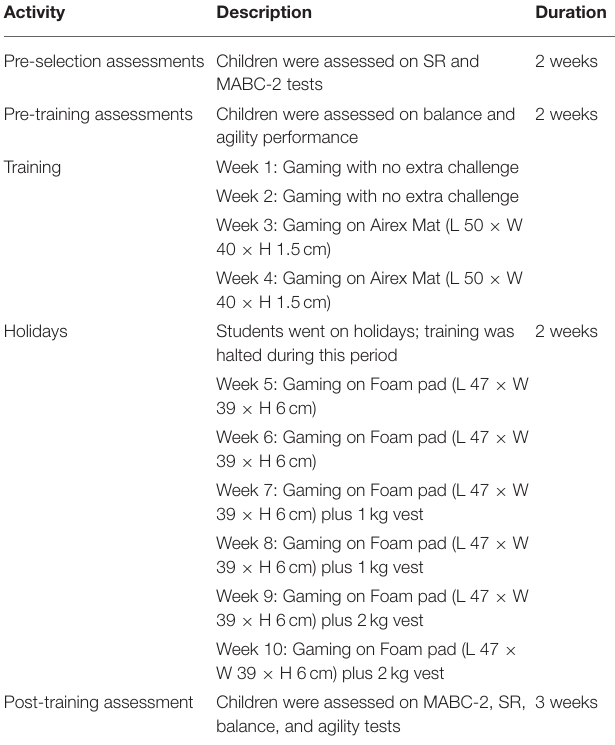
TABLE 1 | Study design. Activity Description